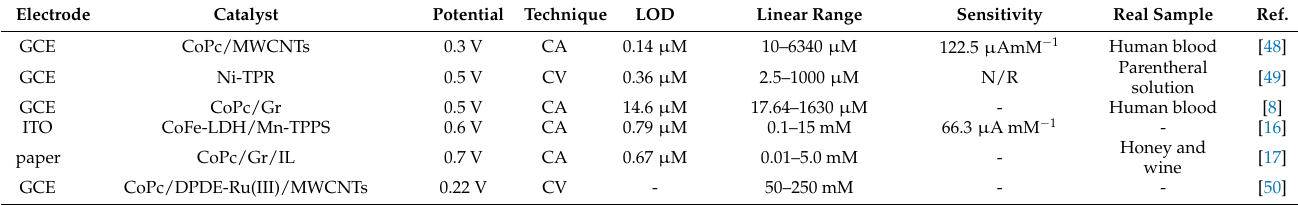
Table 5. Examples of non-enzymatic glucose sensors based on MP an